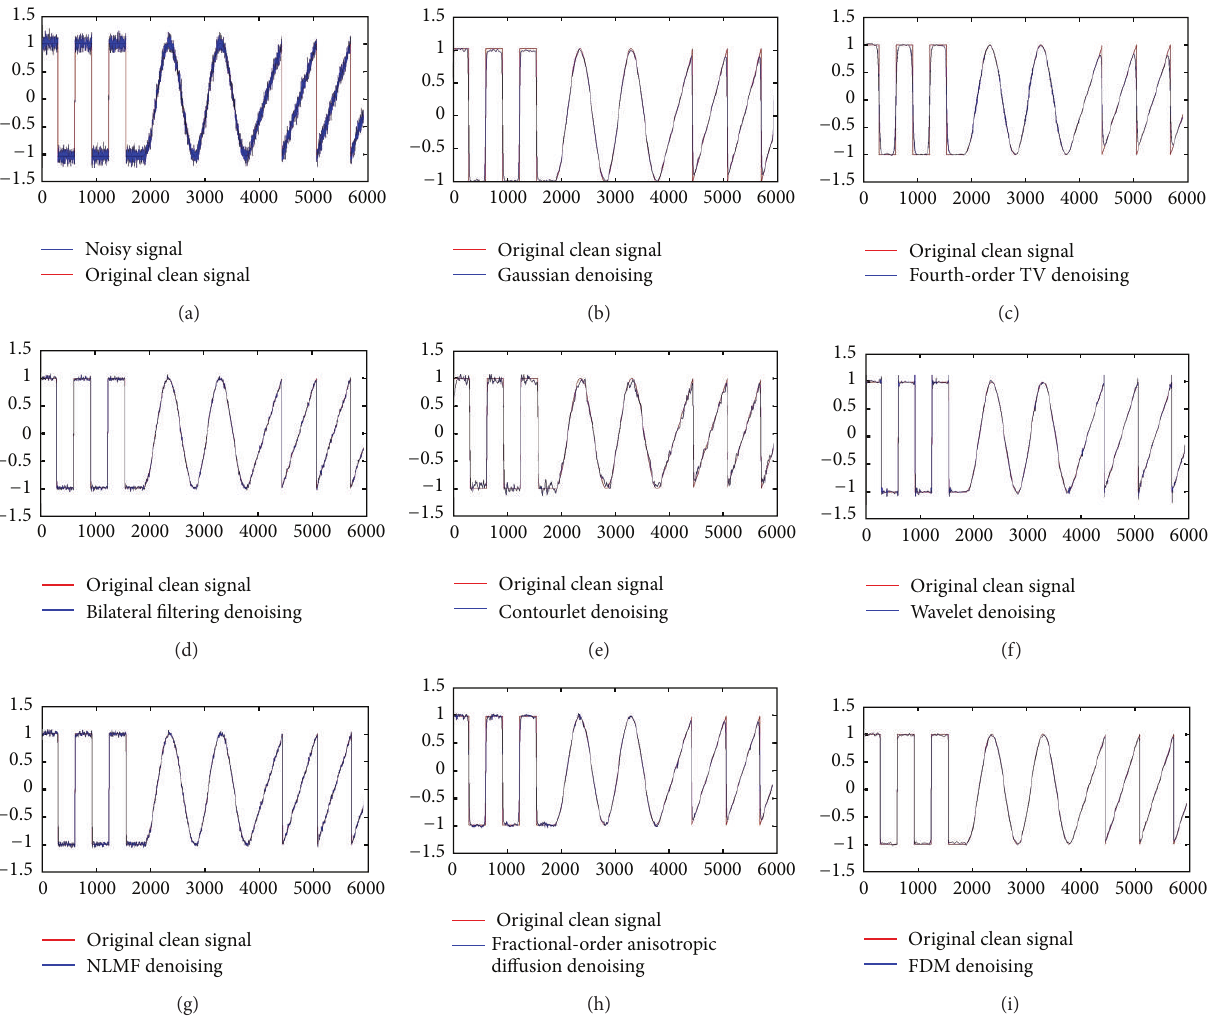
Figure 4: Denoising for integrated one-dimensional signal comprising rectangle wave, sine wave, and sawtooth wave. (a) Original clean signal and noisy signal (adds white Gaussian noise to the original clean signal, peak signal-to-noise ratio (PSNR) = 25.2486), (b) Gaussian denoising, (c) fourth-order TV denoising [71–73], (d) bilateral filtering denoising [86–88], (e) contourlet denoising [89, 90], (f) wavelet denoising [88, 91], (g) nonlocal means noise filtering (NLMF) denoising [92, 93], (h) fractional-order anisotropic diffusion denoising [82], and (i) FDM denoising ( V 1 = 1.025 , V 2 = 2.25 , V 3 = 1.05 , Δ𝑡 = 0.0296